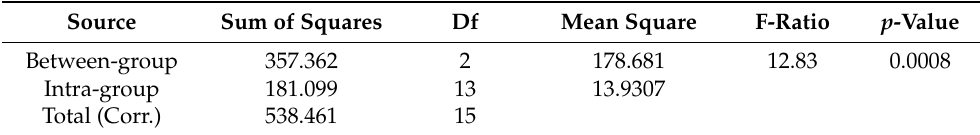
Table 3. ANOVA results for tensile